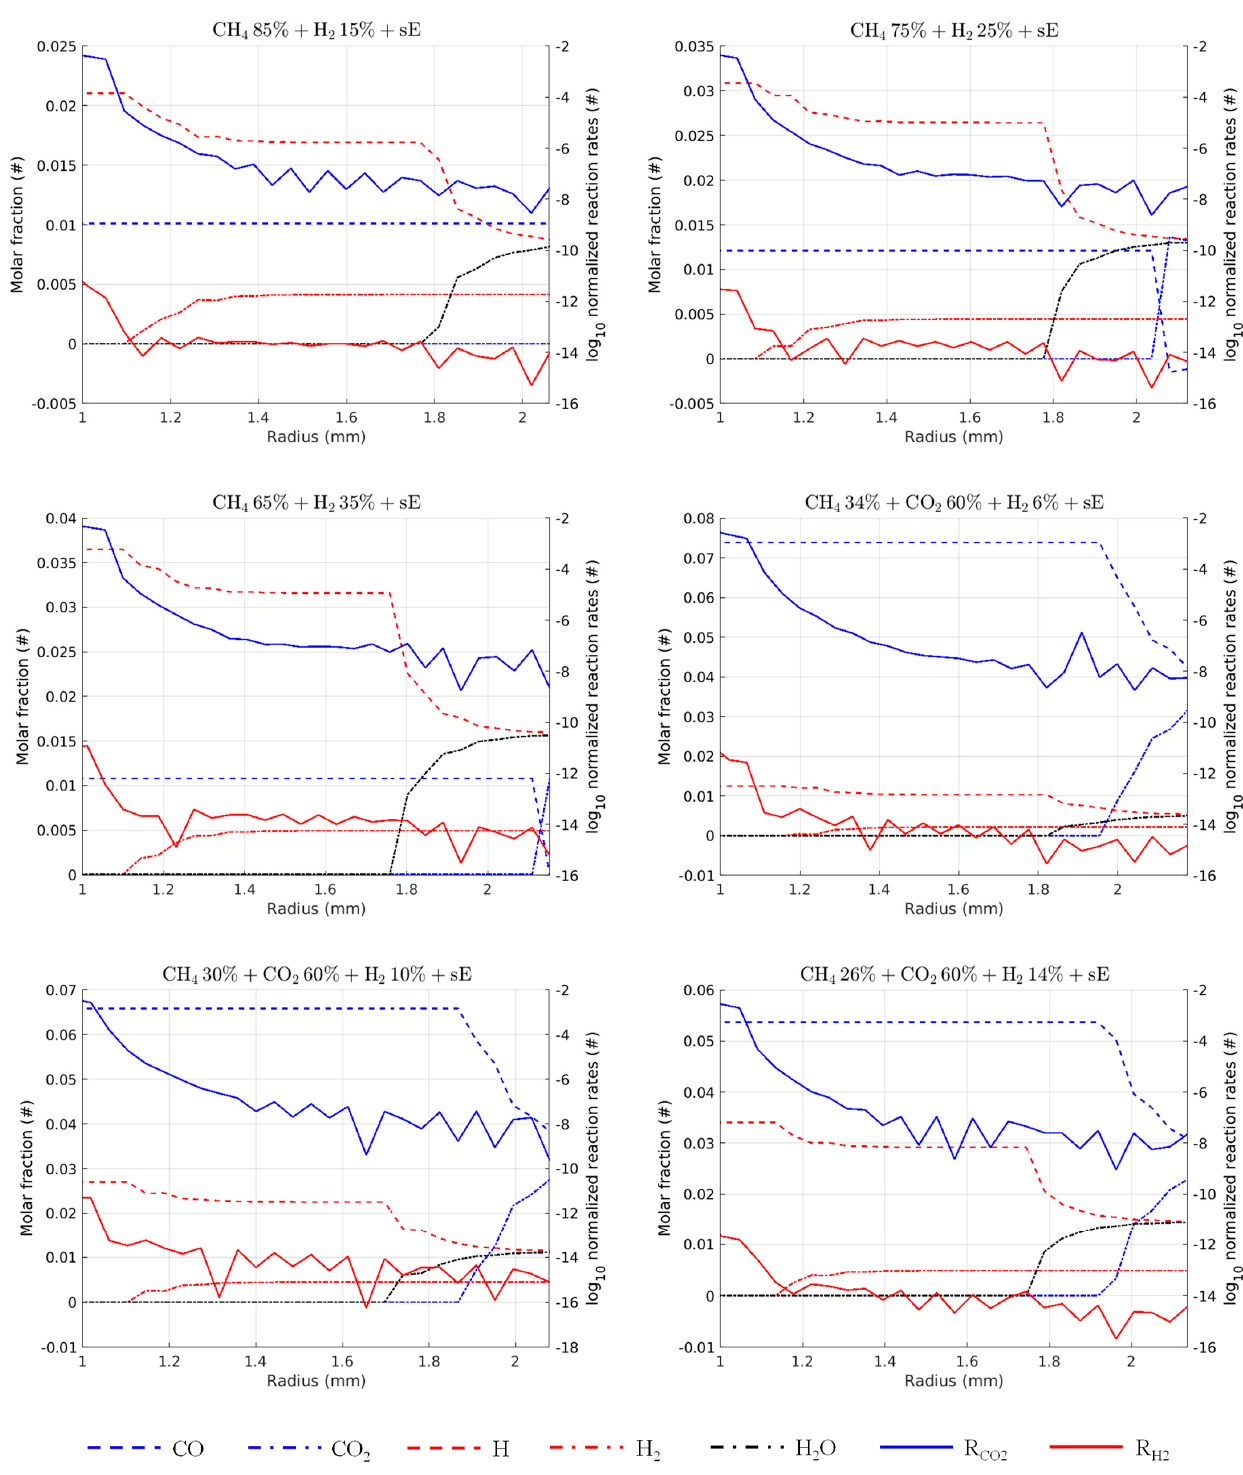
Figure A1. Spatial distribution of carbon monoxide, carbon dioxide, radical hydrogen, molecular hydrogen, water vapor, and of the carbon dioxide and hydrogen dissociation rates. Images for each test fuel (composition reported in the title) at maximum EGR dilution (sE acronym indicating the mixture enrichment with the upper ignition stability EGR value).